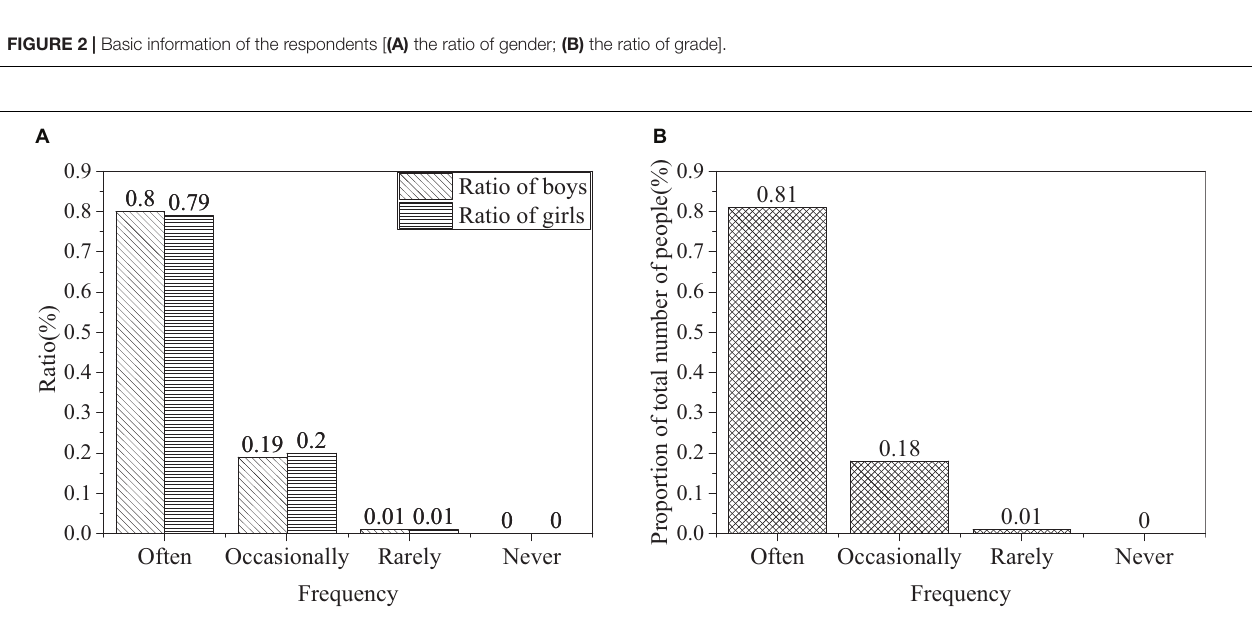
FIGURE 3 | Frequency of college students using the Internet [ (A) the ratio of males and females; (B) the ratio of all].